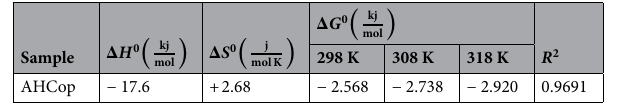
Table 8. Thermodynamic parameters of Pb 2+ adsorption onto AHC op .